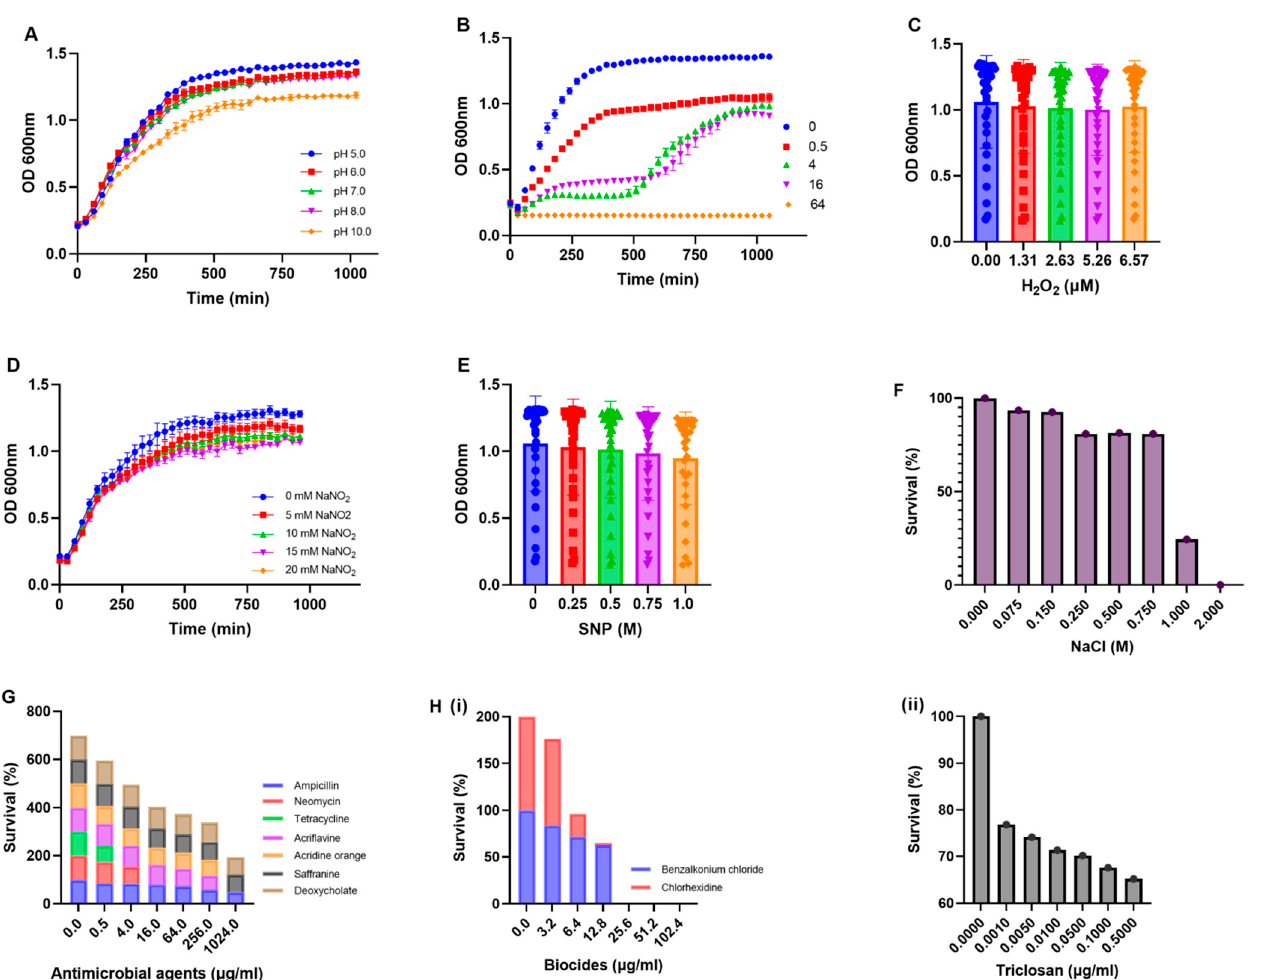
Figure 3. Biological characterization of the E. coli ECU32 strain. The growth profile of the E. coli ECU32 strain was monitored in the presence of different pHs ( A ) and concentrations of norfloxacin ( B ). The growth of the ECU32 strain was monitored in the presence of varied concentrations of oxidative stress-inducing agent—hydrogen peroxide ( C ) and nitrostative stress-inducing agents—sodium nitrite and sodium nitroprusside ( D , E ). The osmotic stress response survival was determined in the presence of sodium chloride concentrations ( F ). The survival ability of the E. coli ECU32 strain was determined under different concentrations of antibiotics [ampillicin, neomycin, tetracycline], bile [deoxycholate], structurally unrelated compounds and dyes [acriflavine, acridine orange, saffranine] ( G ), and biocides [benzalkonium chloride, chlorhexidine, and triclosan] ( H ( i , ii )). The mean values of the different independent experiments were used for plotting graphs, using GraphPad Prism.